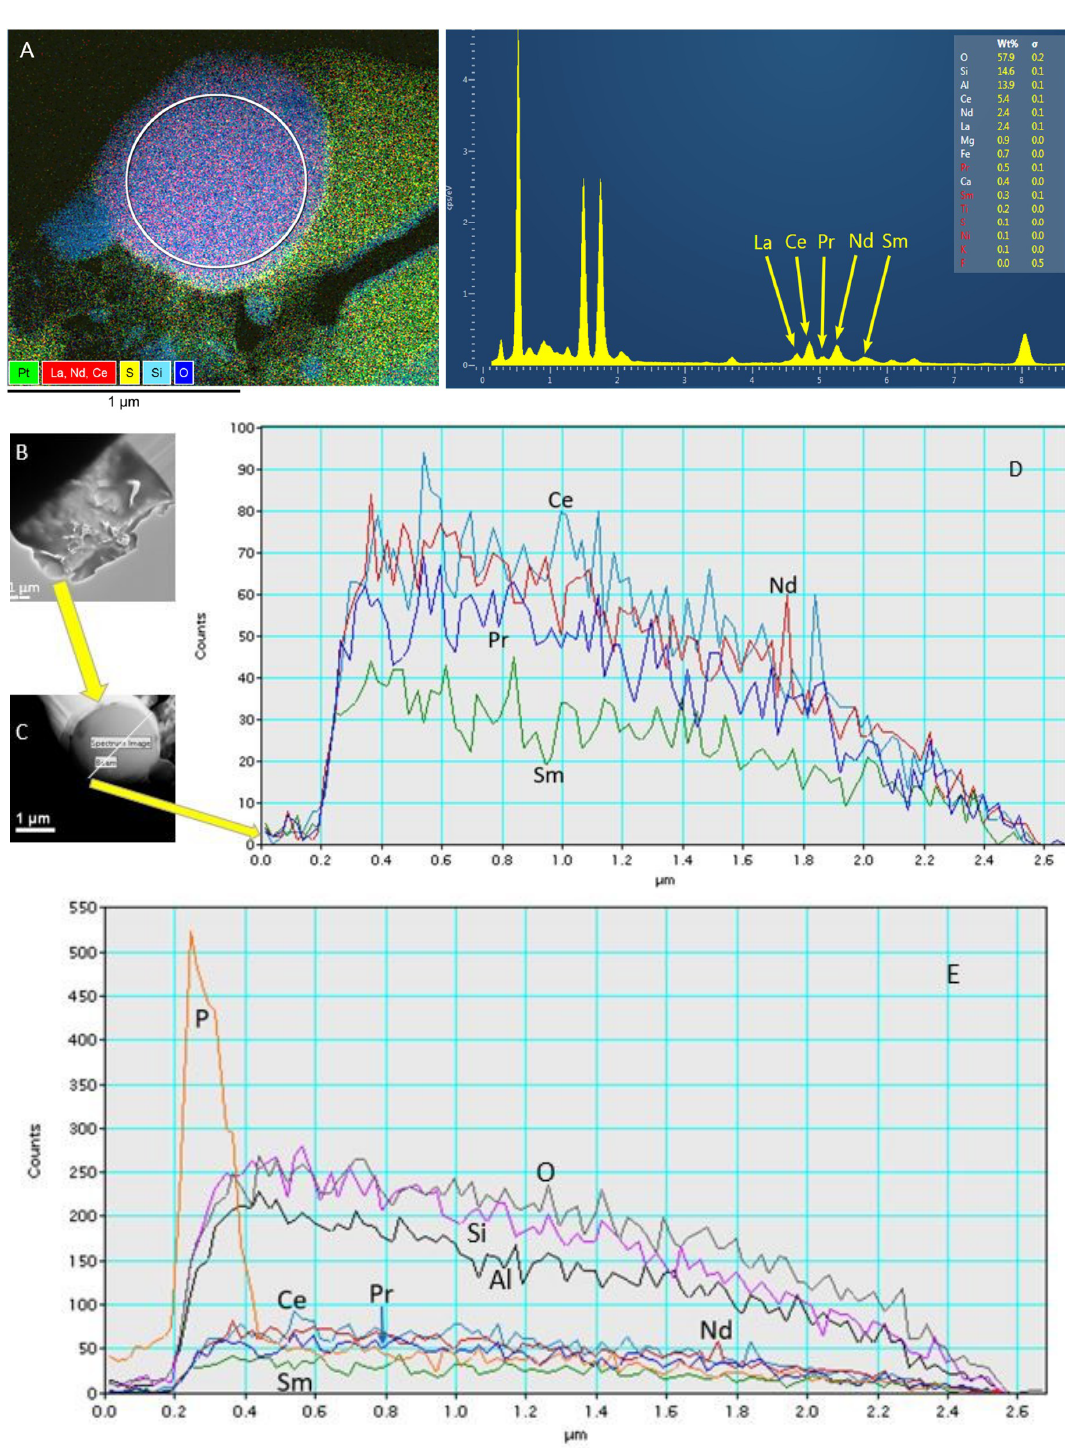
Figure 2. ( A ) EDS scan showing the presence of La, Ce, Pr, Nd, and Sm. ( B ) TEM image of the specimen from focused ion beam (FIB) liftout. ( C ) Expanded spectrum image of an Al–Si glass sphere with the location of beam scan indicated by the white line. ( D ) EDS scan across the diameter of the sphere showing relative concentrations of Ce, Nd, Pr, and Sm. ( E ) Enhancement of Figure 2C to show the relative concentrations of Si, Al, O, and P along with the rare earth elements shown in more detail in Figure 2D.